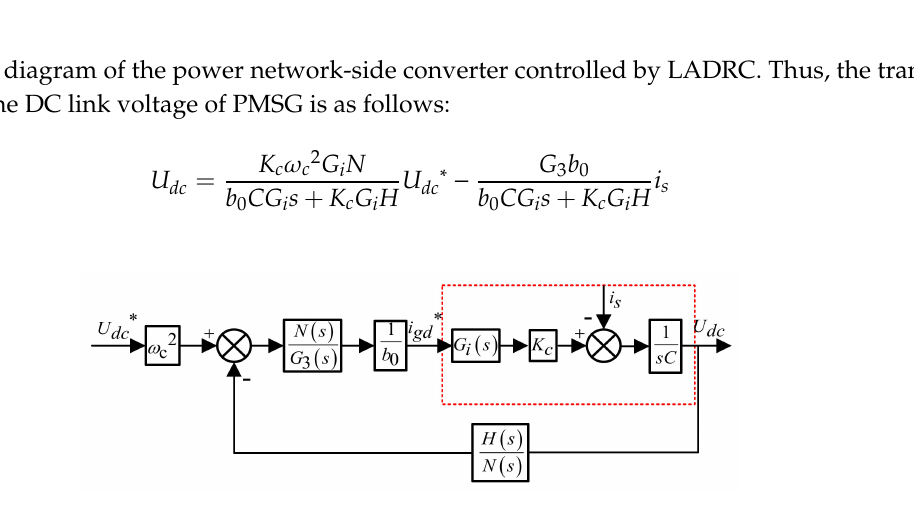
Figure 12. Equivalent control block diagram of the grid-side converter.